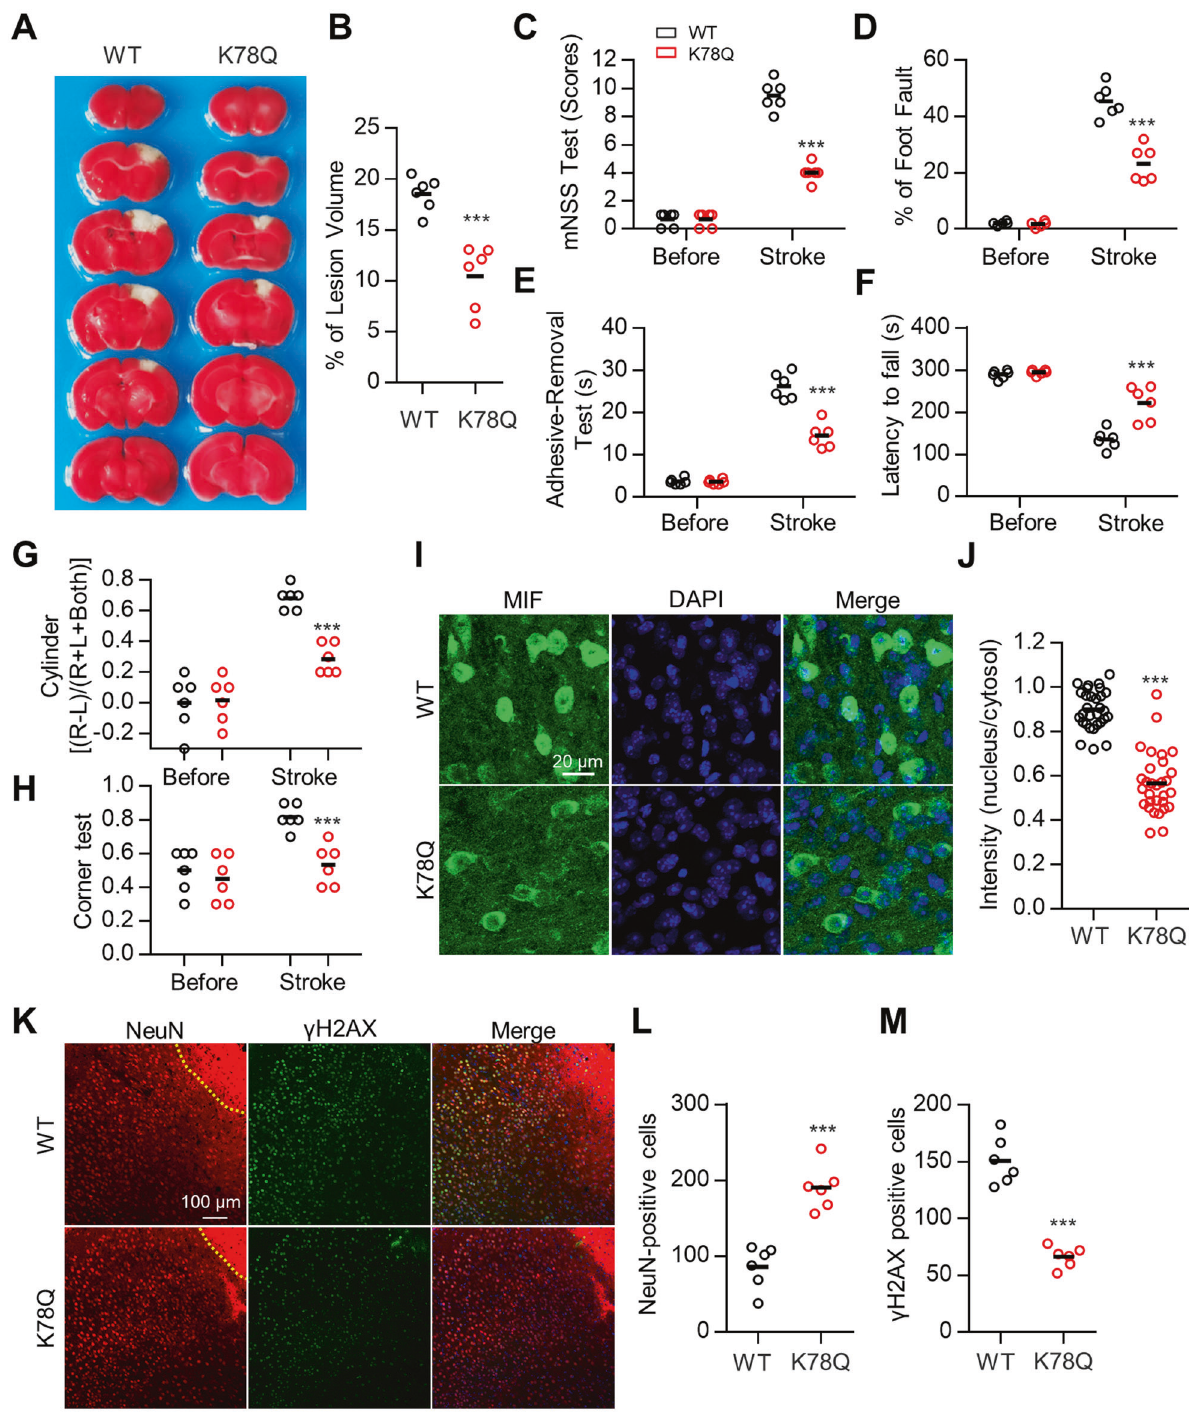
Fig. 6 Reduced brain injury in MIF K78Q knock-in mice after ischemia. A Attenuated infarct volume in MIF K78Q mice after ischemic stroke. Ischemia was induced in WT and MIF K78Q mice and infarct volume was analyzed by TTC staining in brain sections. B Quanti fi cation analysis of lesion volume shown in ( A ). Data shown were independent points and mean; unpaired t -test; n = 6; *** p < 0.001. C – H Quantitative analysis of behavioral tests. Neurological de fi cits were evaluated by the mNSS test ( C ), foot fault assays ( D ), adhesive-removal test ( E ), rotarod assays ( F ), cylinder test ( G ), and corner test ( H ). Data shown were independent points and mean; two-way ANOVA; n = 6; ** p < 0.01; *** p < 0.001. I – M Reduced MIF protein translocation to the nuclei of cortical neurons in MIF K78Q mice after ischemia. Ischemia was induced in WT and MIF K78Q mice. Brain sections were stained with anti-MIF antibody ( I ), anti-NeuN, and anti- γ H2AX antibodies ( K ). J Quanti fi cation analysis of MIF intensity in nucleus/cytosol shown in ( I ). Data shown were mean ± SEM; unpaired t -test; n = 13 cells from three mice; *** p < 0.001. L , M Quanti fi cation analysis of NeuN-positive cells ( L ) and γ H2AX-positive cells ( M ) shown in ( K ). Data shown were independent points and mean; unpaired t -test; n = 6 sections from three mice; *** p < 0.001.